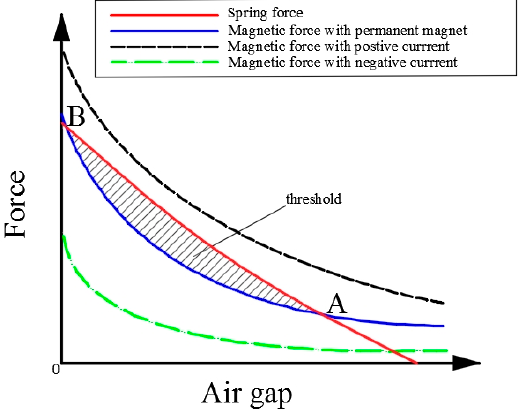
Figure 2. The relationship between the electromagnetic force, the elastic force and the air gap.